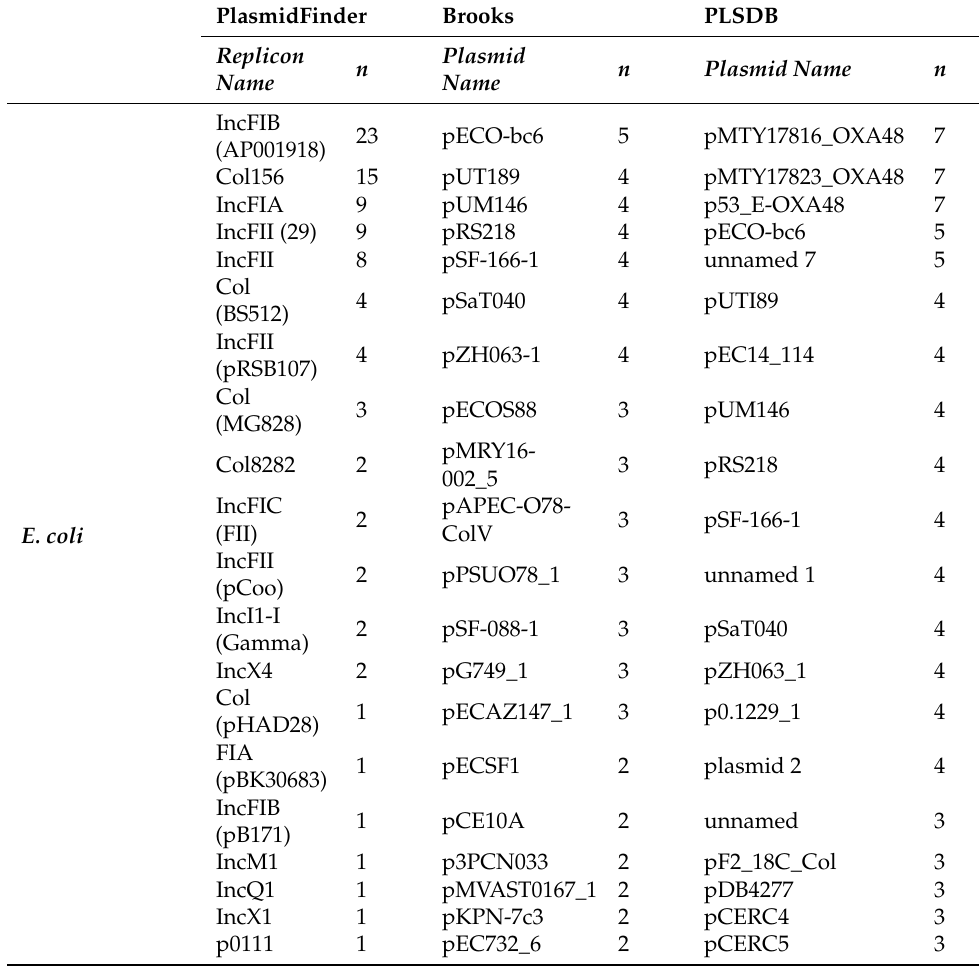
Figure 1. ( A ) Number of uniquely identified putative plasmids ( P TRUE ) using different databases after removing duplicates hits per isolate, for both E. coli and K. pneumoniae. ( B ) phylogenic tree of IncFIB plasmids as the most prevalent plasmids for both E. coli and K. pneumoniae. Table 3. An overview of the top 20 most abundant putative plasmids ( P TRUE ) in both E. coli and K. pneumoniae retrieved from different databases or tools . ( n : number of isolates).